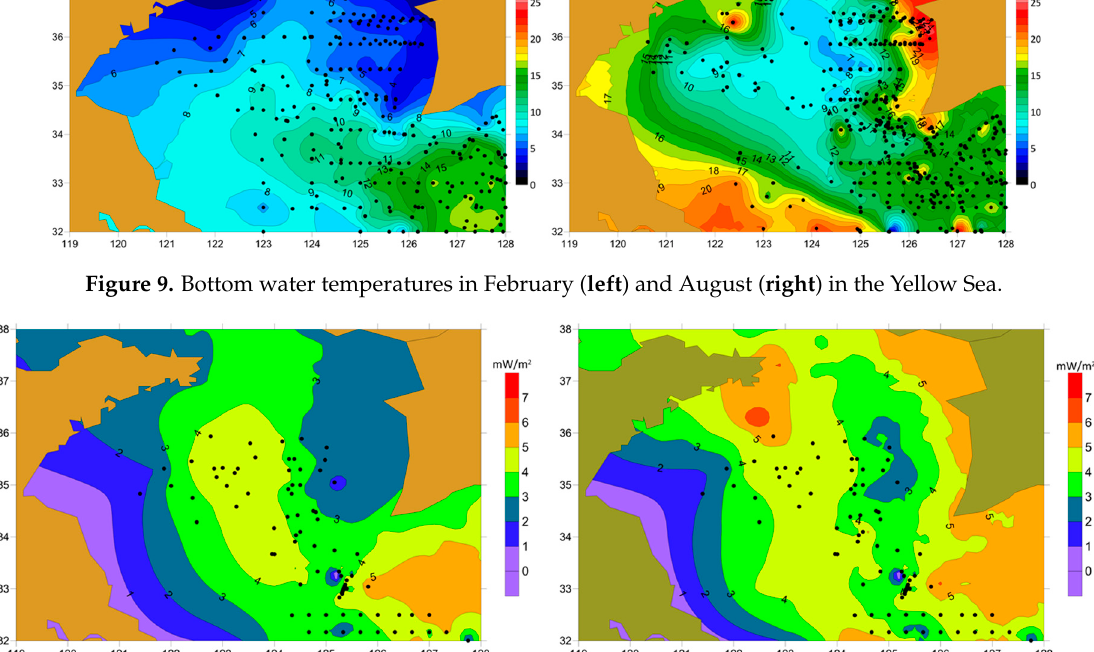
Figure 10. Calculated MFC power density in February ( left ) and August ( right ) in the Yellow Sea.